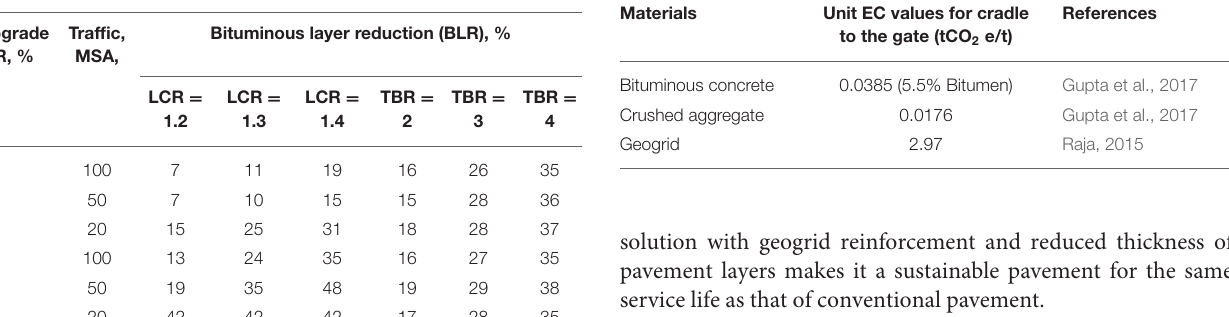
TABLE 3 | Bituminous layer reduction for selected subgrade CBR, traffic, LCR, and TBR values. Subgrade CBR, %